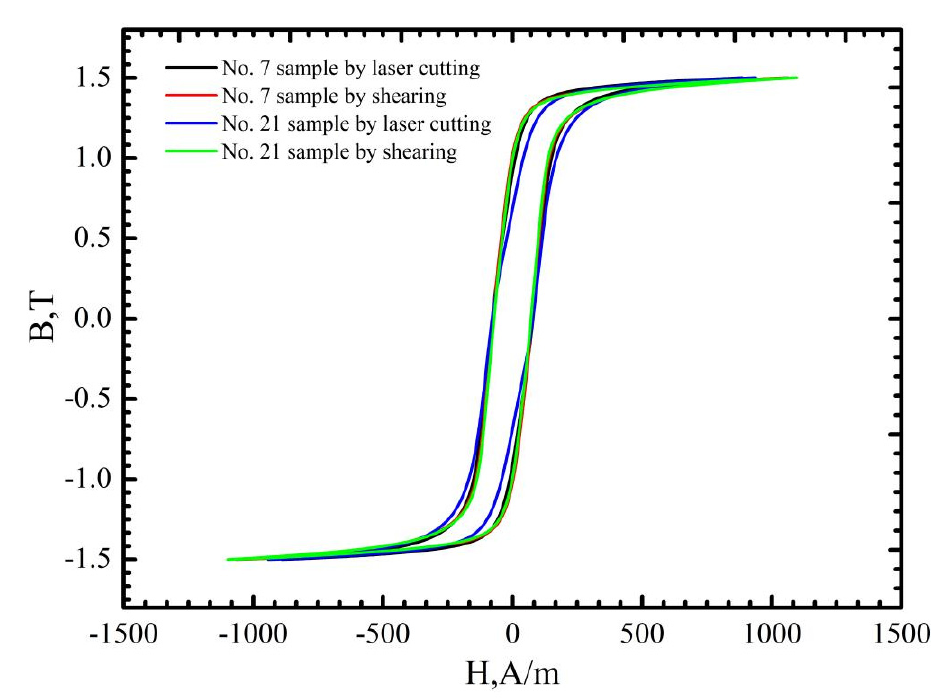
Figure 9. Hysteresis curves at the magnetic induction intensity of 1.5 T of the No. 7 and No. 21 samples processed using laser cutting and mechanic shearing, respectively.